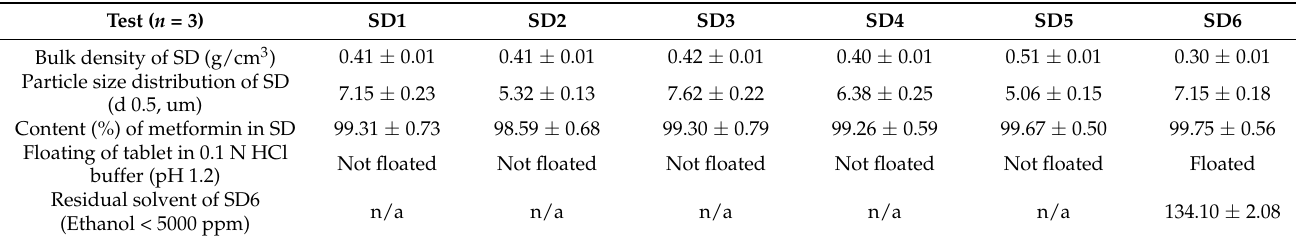
Table 3. Results of the feasibility test for co-solid dispersion (SD)